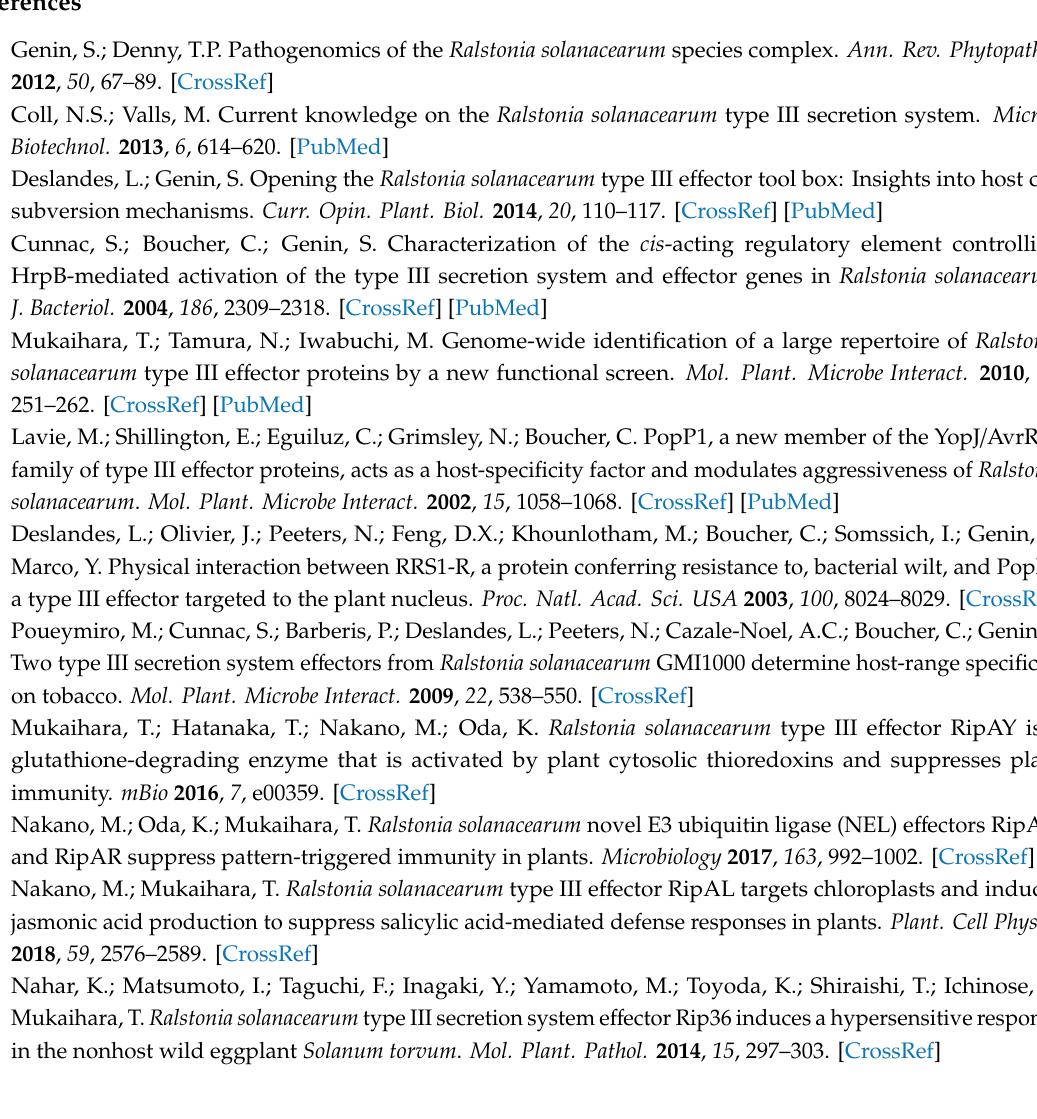
Figure S1: The mitochondrial targeting characteristic of ATPA, Figure S2: Examination of gfp-silenced plants in response to RipX, Figure S3: Sequence analysis of the atpA promoter region, Table S1: ATPA homologs found from Nicotiana benthamiana genome database, Table S2. Bacterial strains and plasmids used in this study, Table S3. Primers used for molecular cloning and qRT-PCR in this